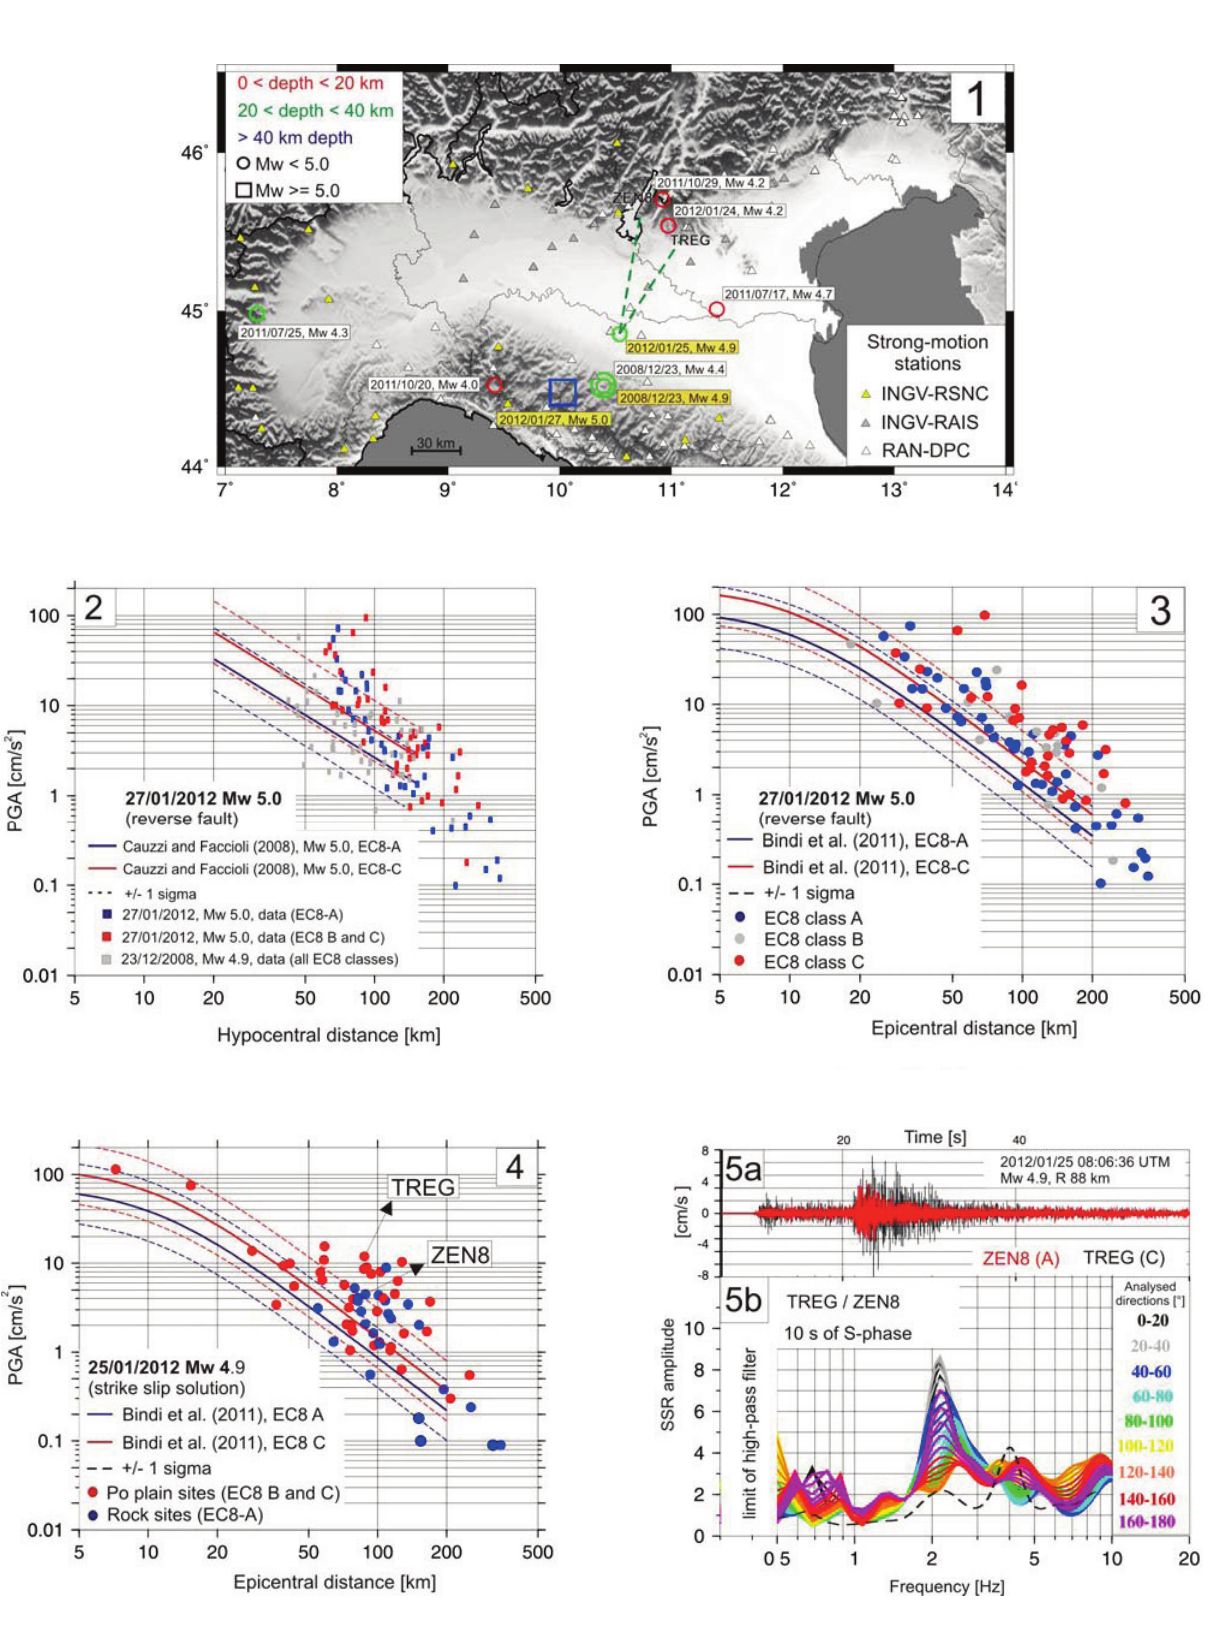
≥ 4, http://cnt.rm.ingv.it/tdmt.html). Yellow insets, analyzed events. 2 : Comparison Panels . 1 : Instrumental seismicity of the area from 2008 to 2012 (M w 5.0, event and the Cauzzi and Faccioli (2008) GMPE. Gray symbols, PGAs recorded for the 2008 between the PGAs recorded for the January 27, 2012, M w 4.9 event. 3 : Comparison between the PGAs recorded for the January 27, 2012, M 5.0, event and the Bindi et al. [2011] GMPE. 4 : Comparison Parma, M w w between the PGAs recorded for the January 25, 2012, M 4.9, event and the Bindi et al. (2011) GMPE. 5a : NS component of the January 25, 2012, event w 4.9) as recorded at the TREG (C class) and ZEN8 (A class) RAIS stations. 5b : Rotational standard spectral ratio (SSR) calculated on 10 s of the S-phases (M w for the January 25, 2012, M 4.9 event as recorded at the TREG station (with ZEN8 as reference). Dashed black line, vertical w